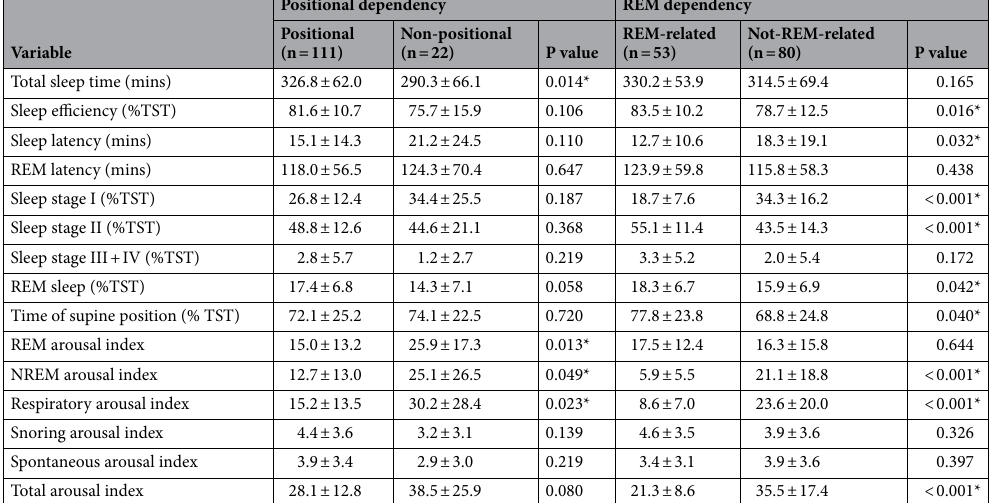
Table 2. Polysomnographic characteristics according to positional and REM dependency-sleep architecture. REM, rapid eye movement sleep; TST, total sleep time; NREM, non-rapid eye movement sleep. a Results were obtained from independent T-test: mean ± SD. *Significant difference: p < 0.05.